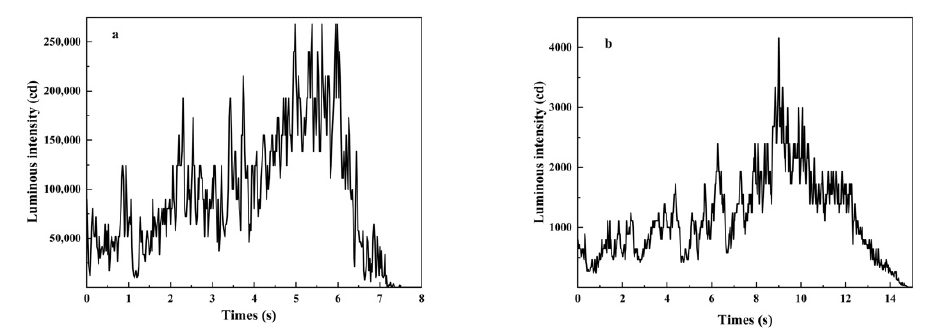
Figure 8. Illuminant and shell combustion light intensity: ( a ) illuminant luminous intensity; ( b ) com- bustible shell luminous intensity.